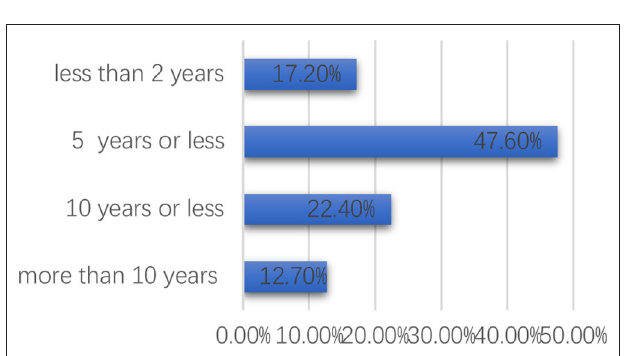
FIGURE 2 | Time spent covering science and